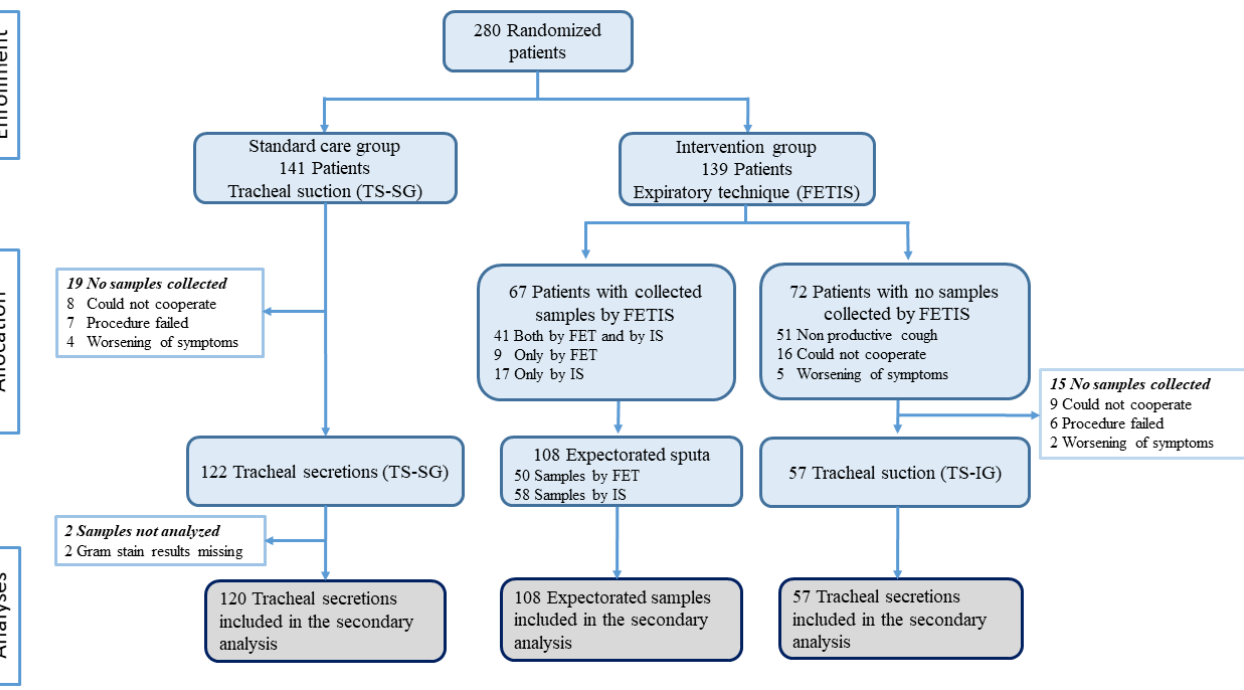
Figure 1. Trial profile and description of the collection of samples. FET: forced expiratory technique; IS: induced sputum; FETIS: forced expiratory technique and induced sputum; TS-SG: tracheal suction standard care group; TS-IG: tracheal suction intervention